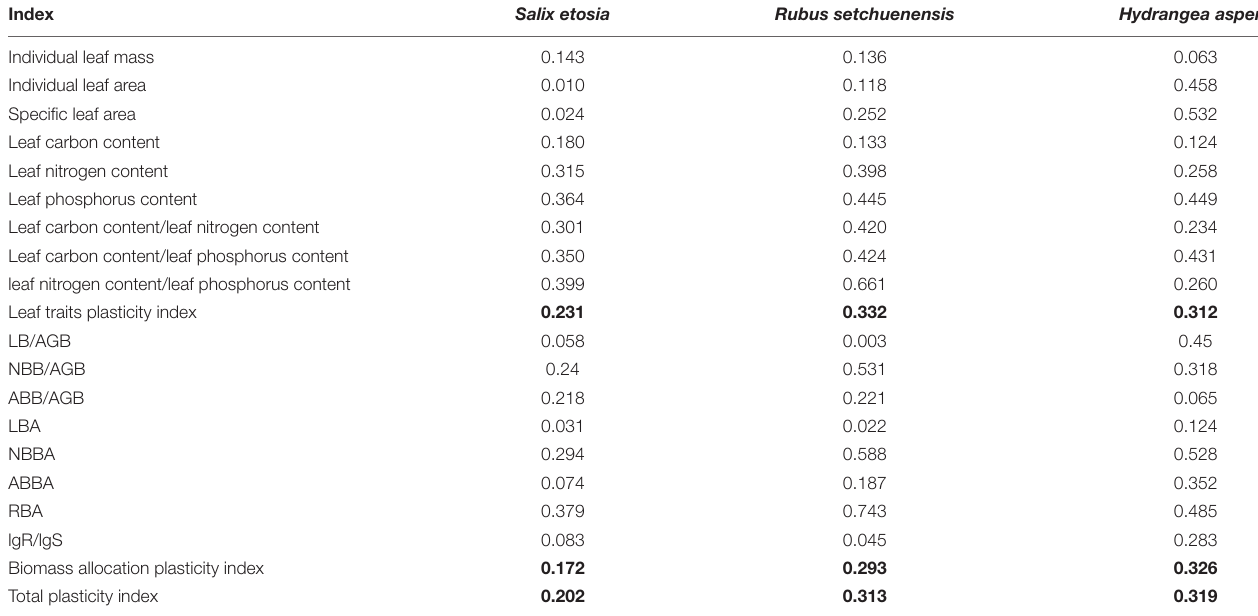
TABLE 5 | Plasticity index comparison of the three shrubs based on leaf traits and biomass